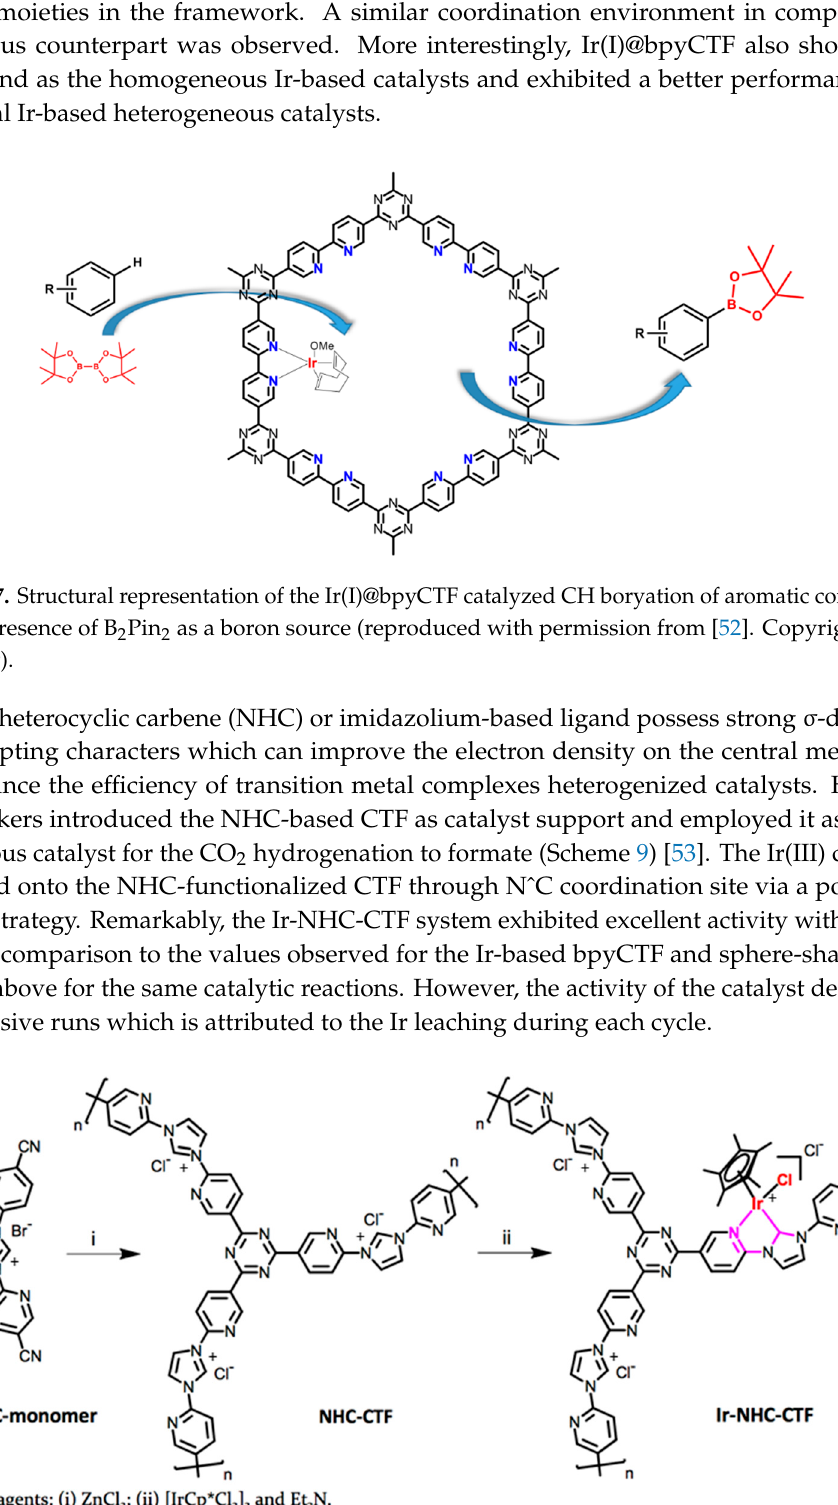
Figure 7. Structural representation of the Ir(I)@bpyCTF catalyzed CH boryation of aromatic compound in the presence of B 2 Pin 2 as a boron source (reproduced with permission from [52]. Copyright 2019,